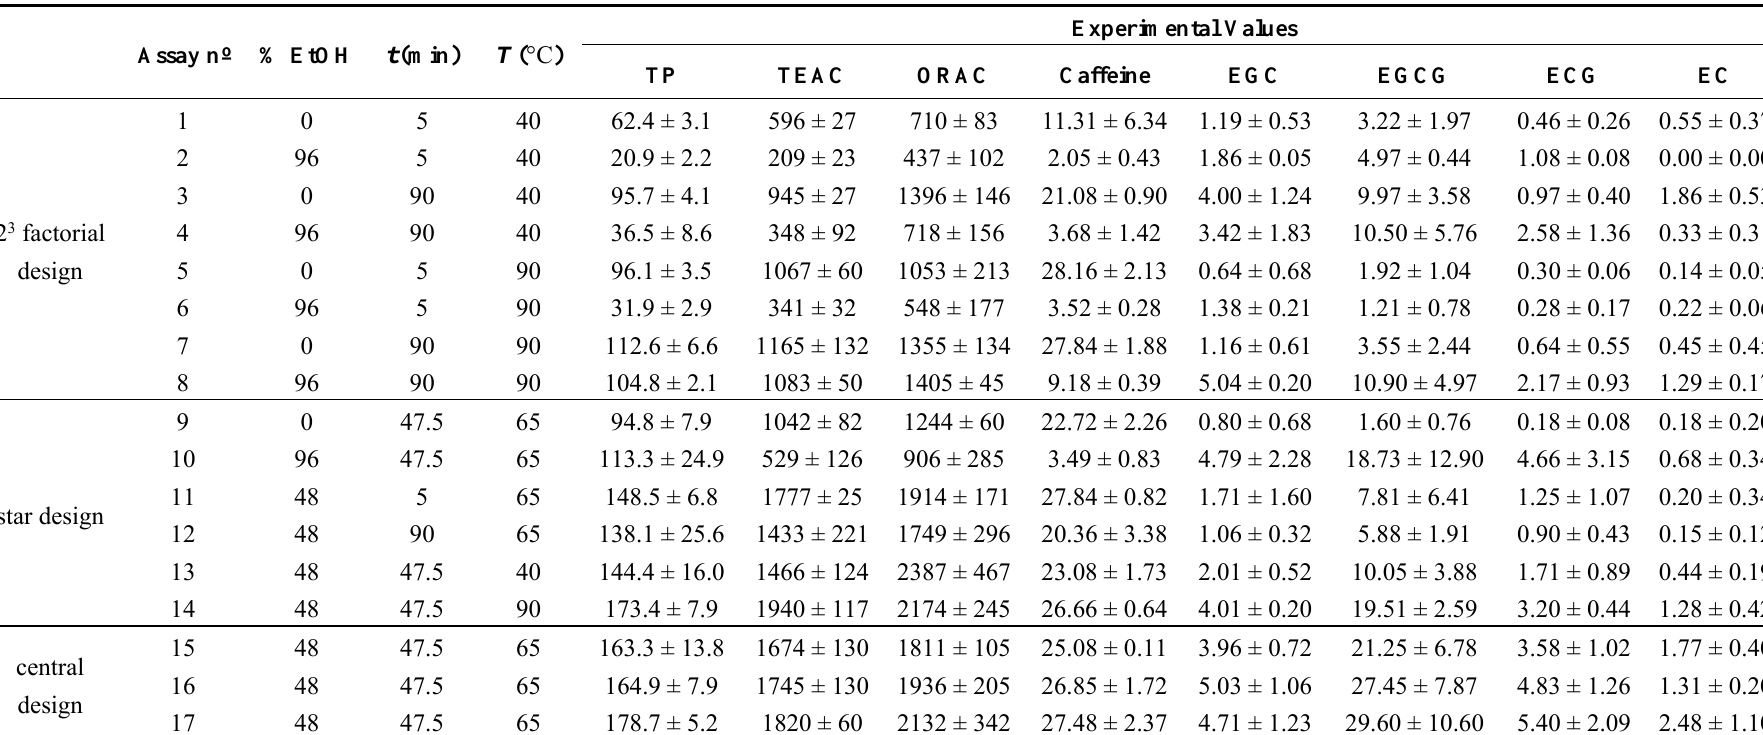
Table 2. Experimental design obtained and the experimental values obtained from the determination of total polyphenols, antioxidant capacity of the extracts assessed by TEAC and ORAC and polyphenol